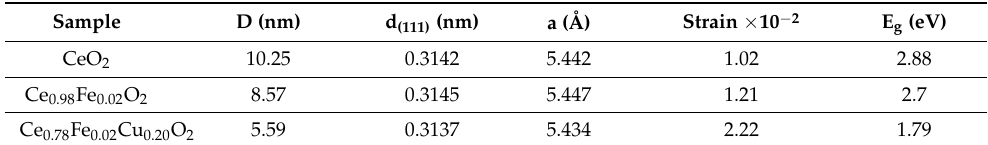
Table 1. The values of various parameters obtained, such as crystallite size (D), FWHM (d), lattice strain through XRD, and bandgap energy (Eg) from UV-vis analysis of pure CeO 2 , doped CeO 2 , and co-doped CeO 2